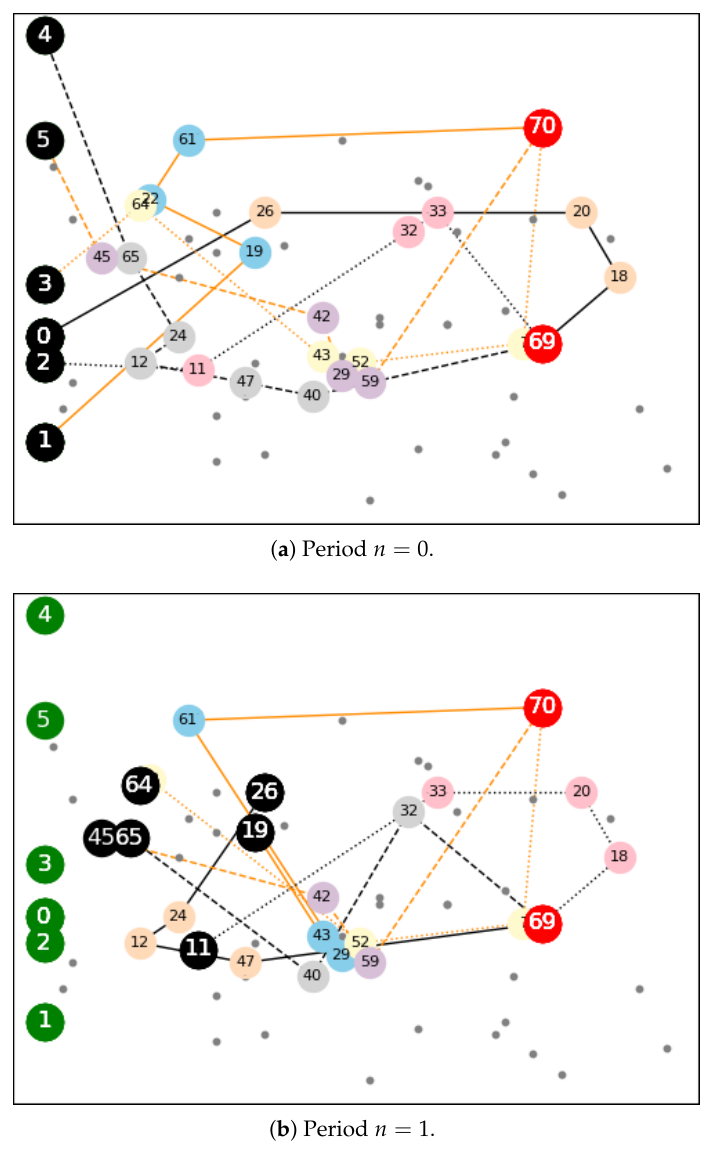
Figure 6. Example of the BFS for the instance drsp63x6-2 in the periods n = 0 and n =